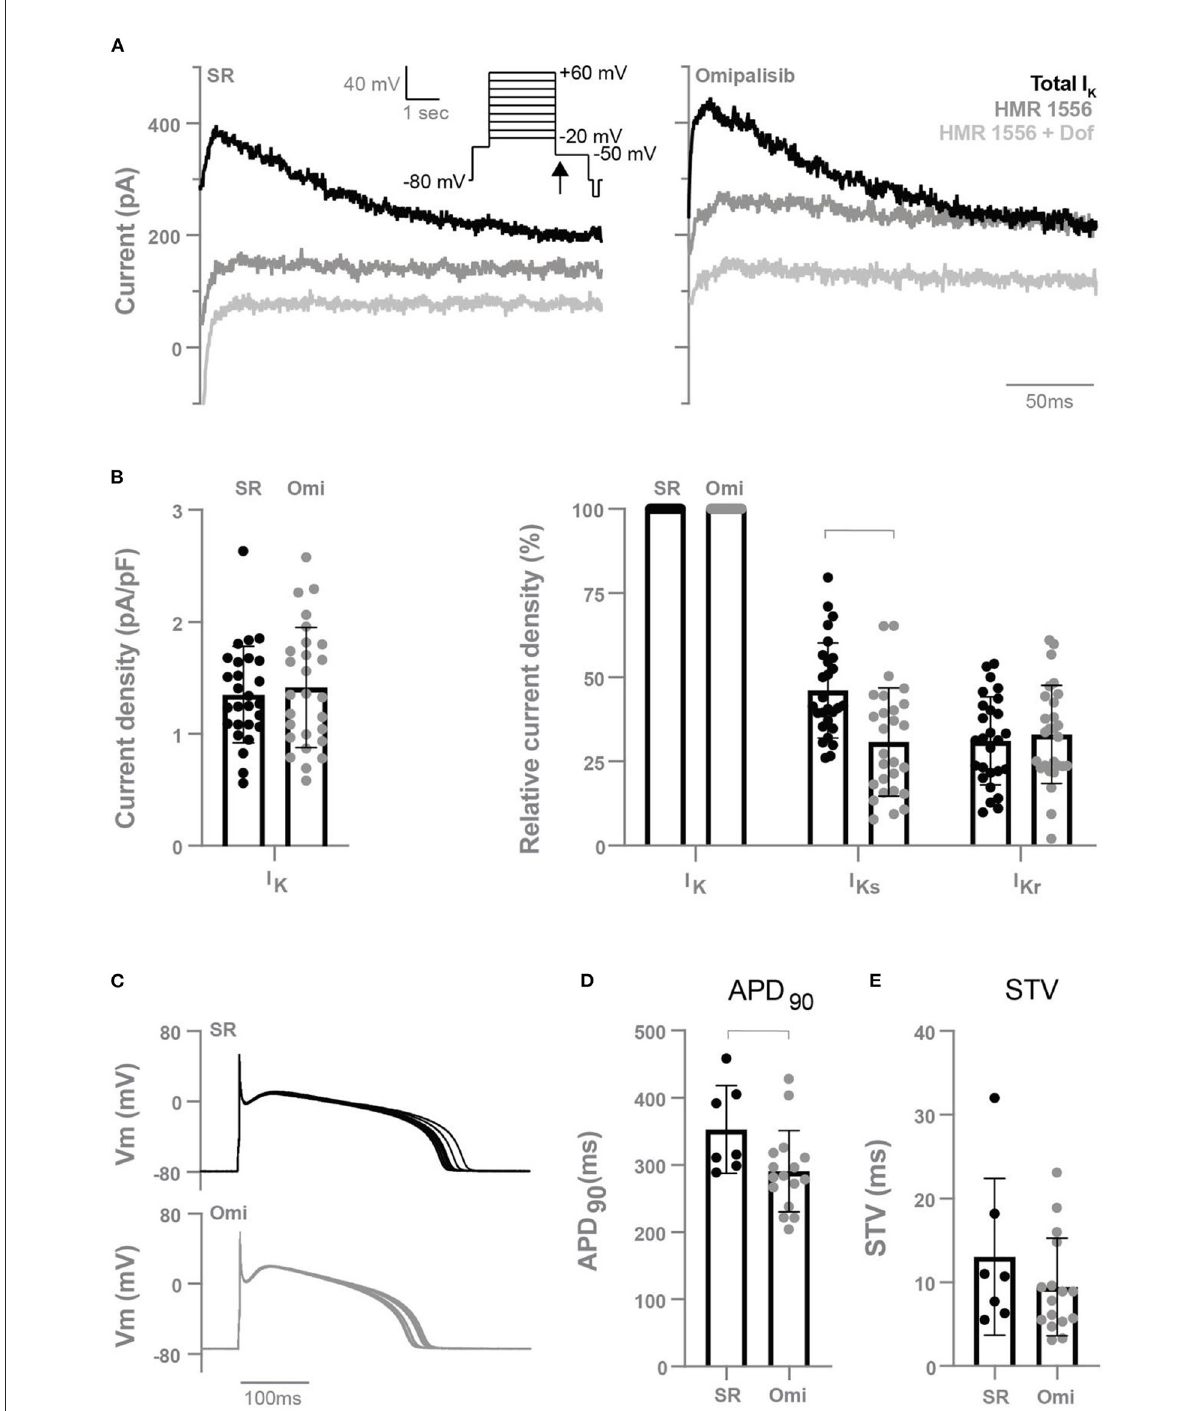
FIGURE5 Electrophysiological measurements of isolated cardiomyocytes from the left and right ventricle of dogs in sinus rhythm (SR) and after 1 mg/kg omipalisib twice a day (Omi). (A) Representative peak tail current tracings at 50mV (arrow). (B) Current density of total I K (left graph, n 27, − = unpaired t -test, not significant) and relative current density of I Ks and I Kr to total I K (right graph, n 27, repeated measures two-way ANOVA with = Bonferroni’s multiple comparisons test SR vs. Omi, bar refers to p < 0.05). I Ks refers to the current blocked by 500nM HMR 1556 and I Kr refers to the current blocked by 1 µ M dofetilide (Dof). (C) Representative action potential tracings. Membrane potential (Vm). (D) Action potential duration at 90% of repolarization (APD 90 ) and (E) short term variability (STV) of repolarization at SR ( n 7) and Omi ( n 16). Unpaired t -test, bar refers to = = p < 0.05. Data are presented as mean ±